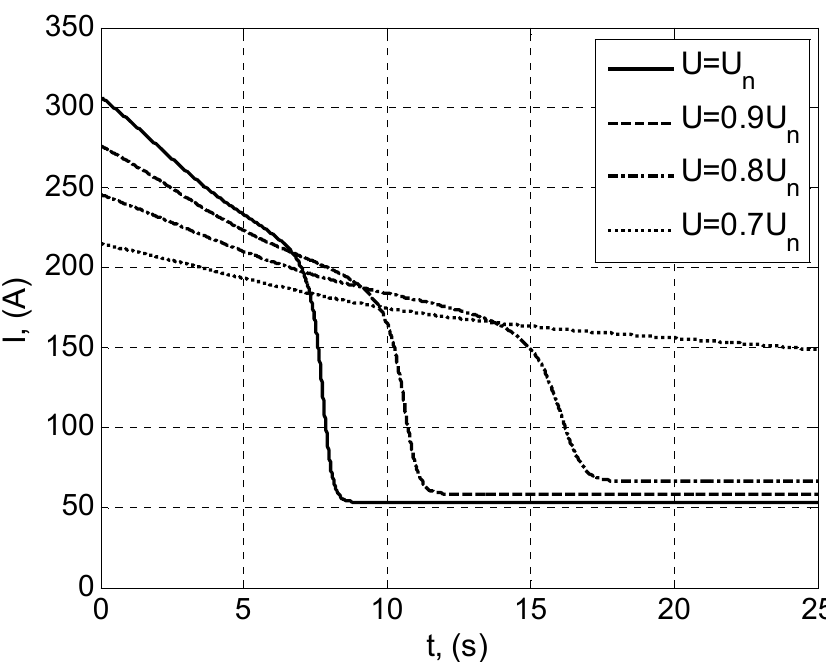
Figure 5. Course of motor current while powered by voltage in the range between 0.7 ⋅ U n and U n.